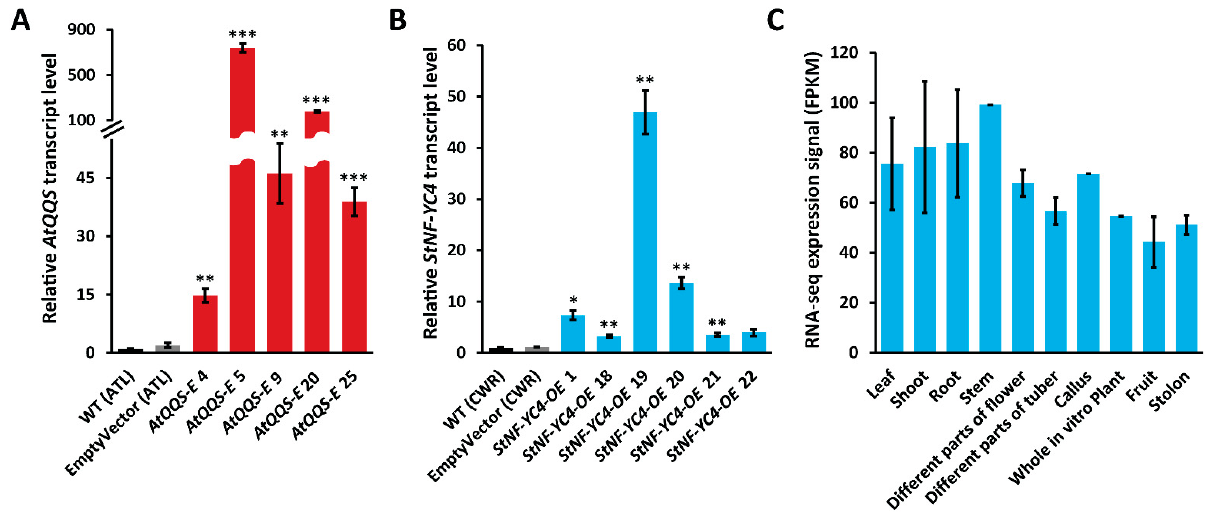
Figure 2. Expression of AtQQS , StNF-YC4 in transgenic potato tubers and StNF-YC4 expression in potato plant. Relative transcript levels of AtQQS ( A ) and StNF-YC4 ( B ) in the tuber tissue of transgenic potatoes were quantified using the EF-1 α gene as a reference by RT-qPCR. RNA-Seq expression signal (FPKM) of StNF-YC4 ( C ) in different organs of potato plants. The data set was collected from publicly available online resources [37–39]. All data in the bar chart show mean ± SE, n = 3. All tubers in ( A ) are of ATL variety, and tubers in ( B ) are of CWR variety. Student’s t -test was used to compare AtQQS-E , StNF-YC4-OE , and corresponding WTs in ( A , B ), *** p < 0.001; ** p < 0.01; * p < 0.05.